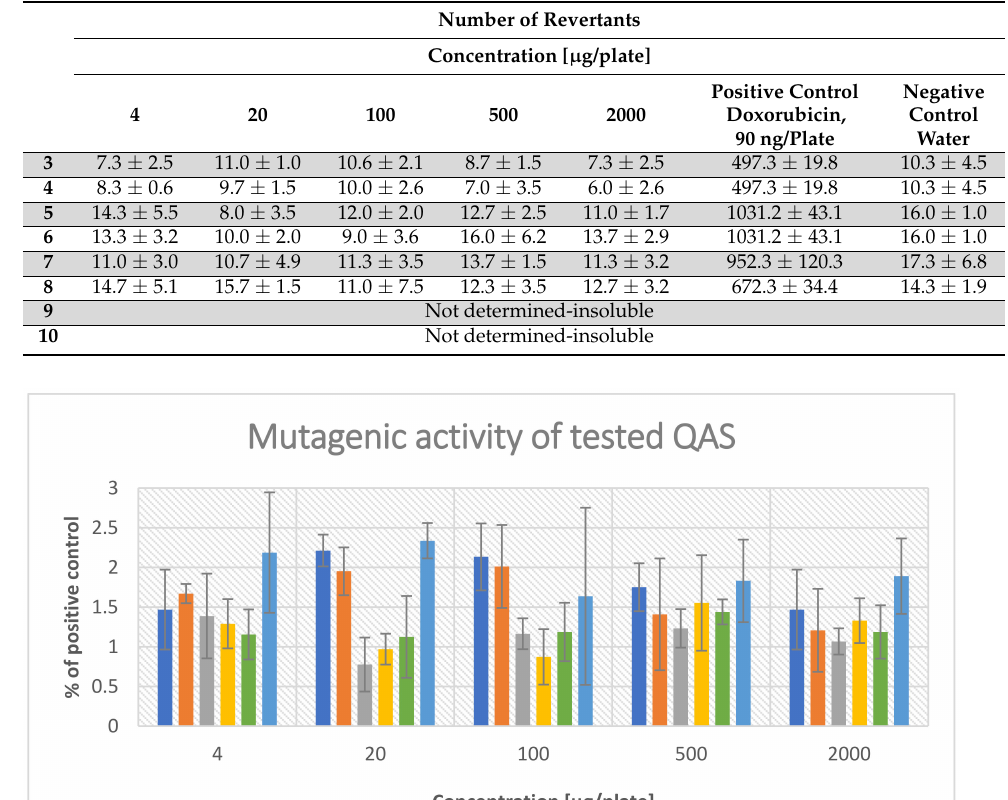
Table 3. Mutagenic activity of QAS 3–10 in Ames test with Salmonella typhimurium TA 98 strain.